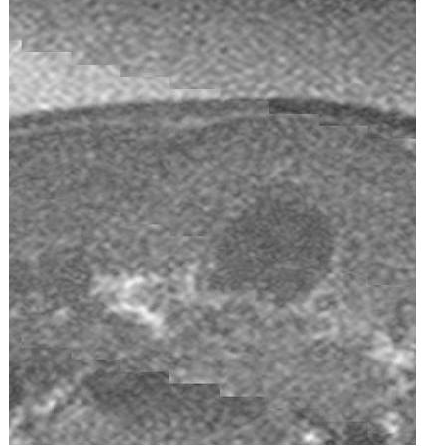
Figure 9. The estimated cross section of the MR image corresponding to the cross section of the ultrasound image according to coordinates of MR-visible fiducial markers.